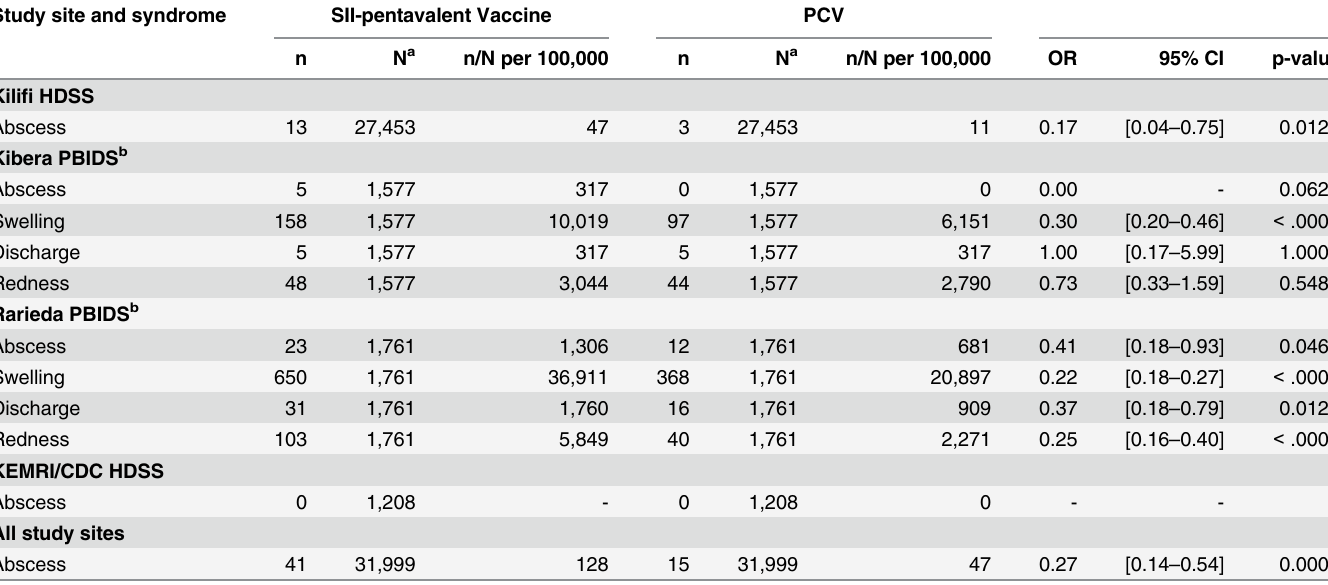
Abbreviations: CDC, Centers for Disease Control and Prevention; CI, con fi dence interval; HDSS, Health and Demographic Surveillance System; PBIDS, Population-based Infectious Disease Surveillance Site; KEMRI, Kenya Medical Research Institute; OR, odds ratio; SII, Serum Institute of India; VAEIK, Vaccine Adverse Events in Kenya a Denominator is the number of vaccine doses administered. Data represent matched vaccine encounters in which the infant received both pentavalent vaccine and PCV10 at the same visit. b PBIDS data represent household- and health facility-based surveillance combined; no abscesses or related symptoms were identi fi ed at the PBIDS health